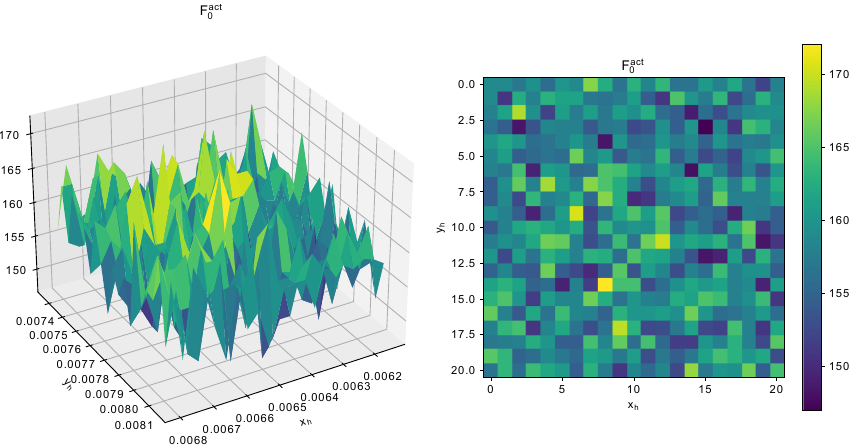
Figure 11. Dependence of F act around scaled solution for 5-mode resonator. 0 As can be seen from Figure 11, the landscape of the function is rather rough, that is there are many local optima, and even a small change in geometrical characteristics may cause significant change in F 0 , which jumps from 150 to 170. Figures 12 and 13 show similar graphs for dF and number of modes.